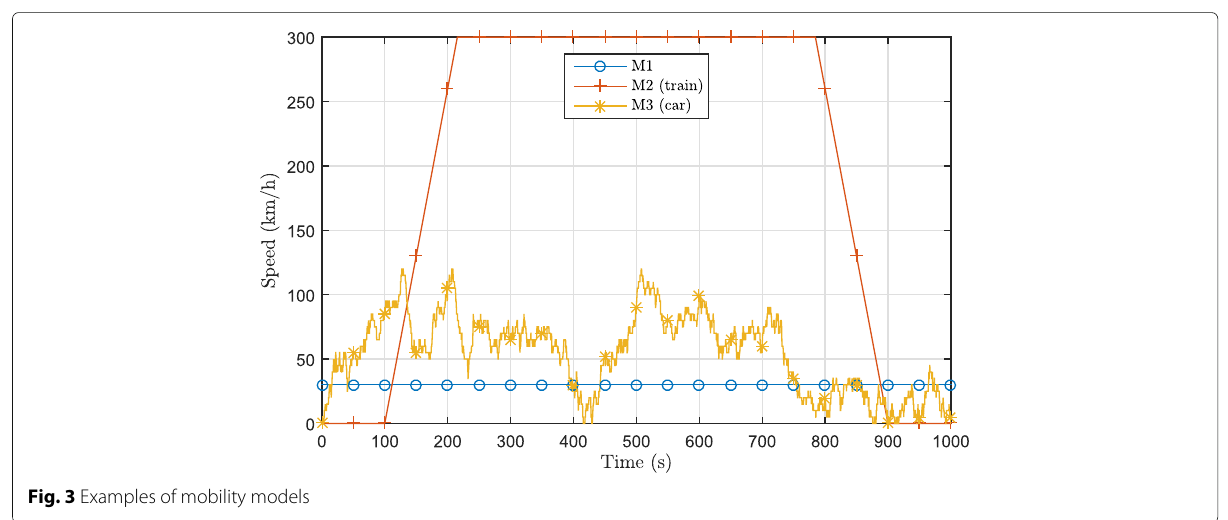
Fig. 3 Examples of mobility models